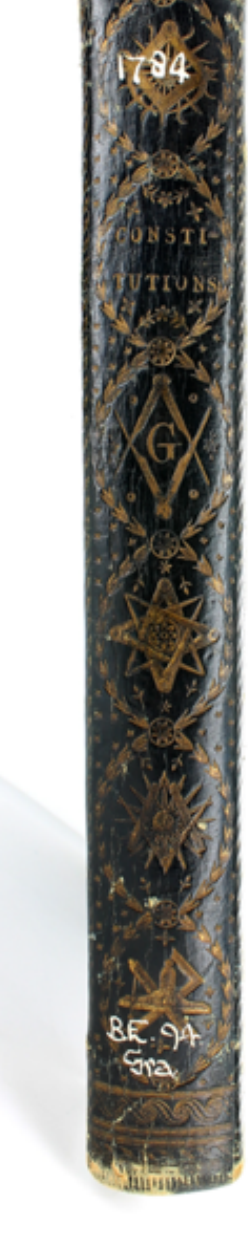
Fig 19. Spine of Constitutions of the … Masons (London, 1784) bound by Henry Walther. Note scuffed leather at top and tail. Copyright and reproduced by permission of the Museum of Freemasonry, London.